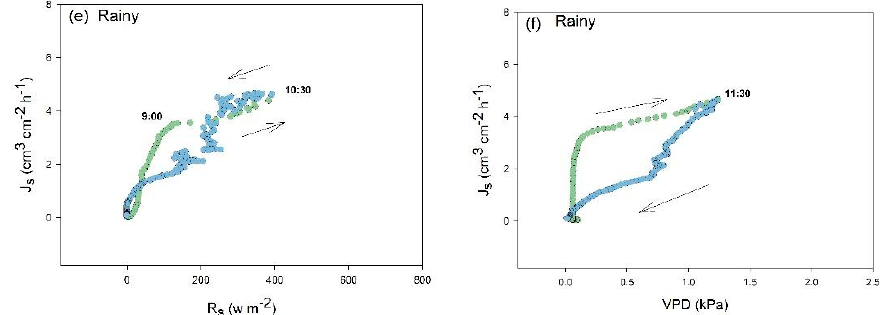
Figure 4. Hysteresis loop between sap flux density (J s ) and environmental factors under different weather conditions: ( a ). Hysteresis loop between J s and solar radiation (R s ) on sunny days; ( b ). hysteresis loop between J s and vapor pressure deficit (VPD) on sunny days; ( c ). hysteresis loop between J s and R s on overcast days; ( d ). hysteresis loop between J s and VPD on overcast days; ( e ). hysteresis loop between J s and R s on rainy days; ( f ). hysteresis loop between J s and VPD on rainy days. A clockwise pattern in the J s -R s relationship indicates that J s precedes R s , and a counterclockwise pattern in the J s -R s relationship indicates that J s lags R s . The clockwise pattern in the J s -VPD relationship indicates that J s precedes VPD. The arrows mark the direction of the hysteresis. Time zone: GMT+8.